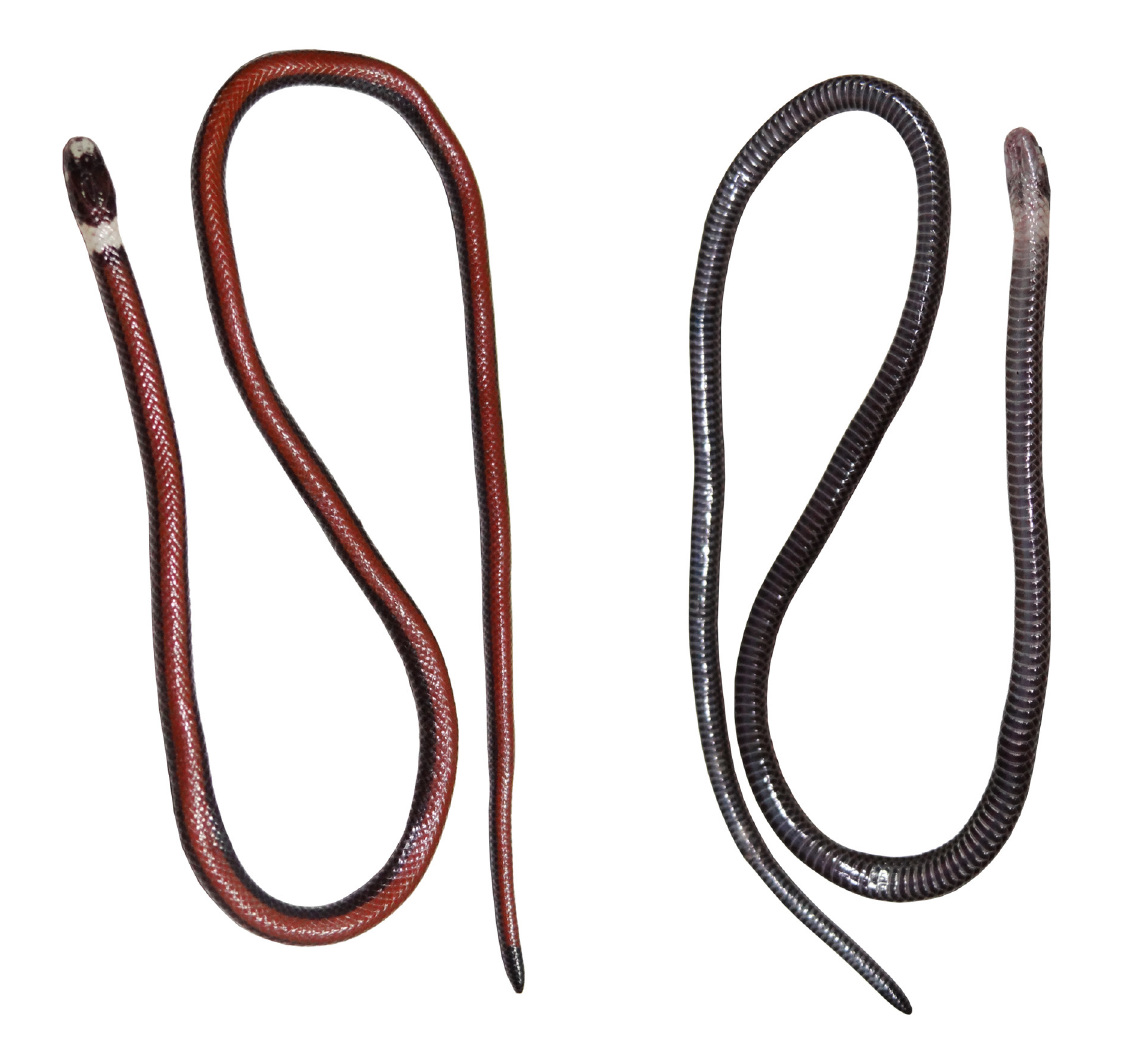
Fig. 13. Apostolepis quirogai Giraudo & Scrocchi, 1998, adult specimen from Misiones, Argentina, in dorsal and ventral view. Photograph credits: Amado